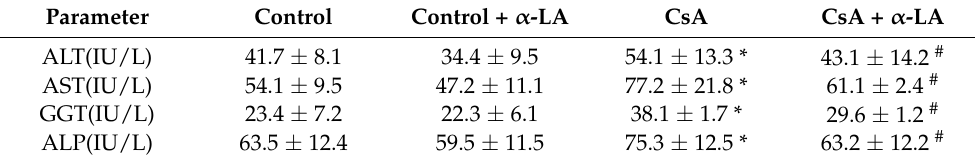
Table 1. Effect of α -LA administration on serum liver function tests in CsA-treated animals. Parameter